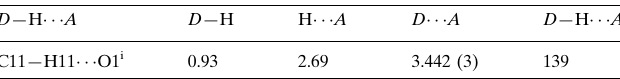
Hydrogen-bond geometry (A˚ , (cid:2)